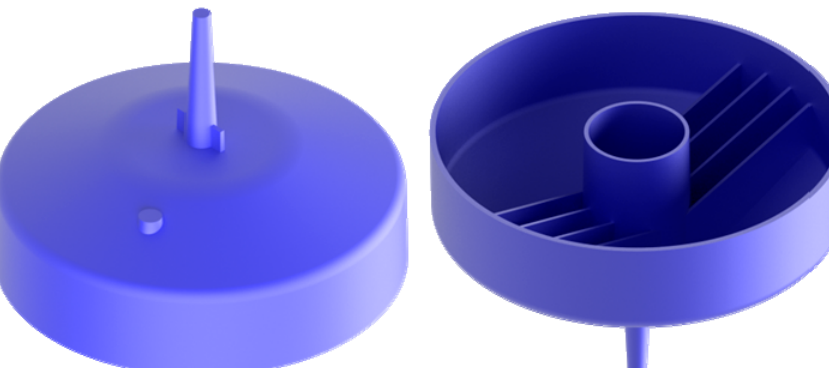
Figure 3. The reference molded part.